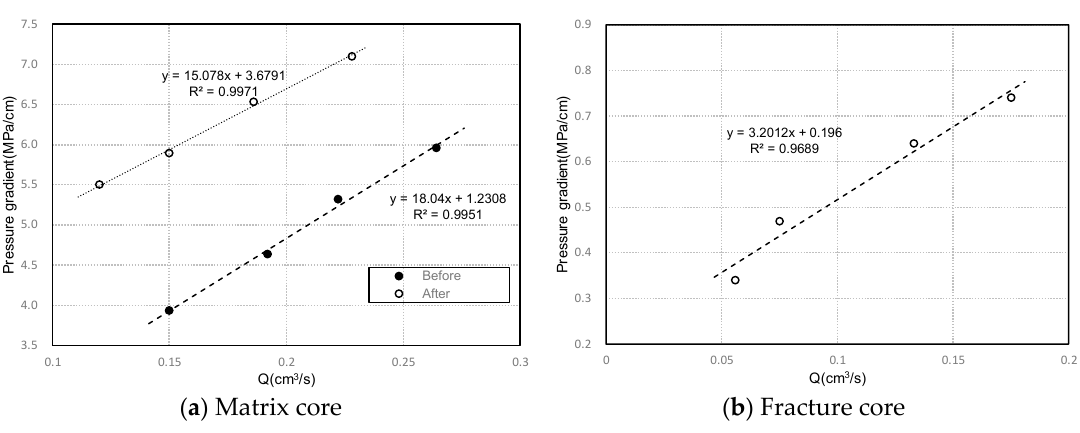
( b ) Fracture core Figure 8. Comparison of core permeability before and after water injection. 3.2.3. Comparing Experiments of Starting Pressure Compared with the core starting pressure before gas-field water injection, it can be seen from the results of water flooding that the core starting pressure changed significantly after water injection (Figure 9). For the matrix core (Figure 9a), the starting pressure gradient of the core was 1.2308